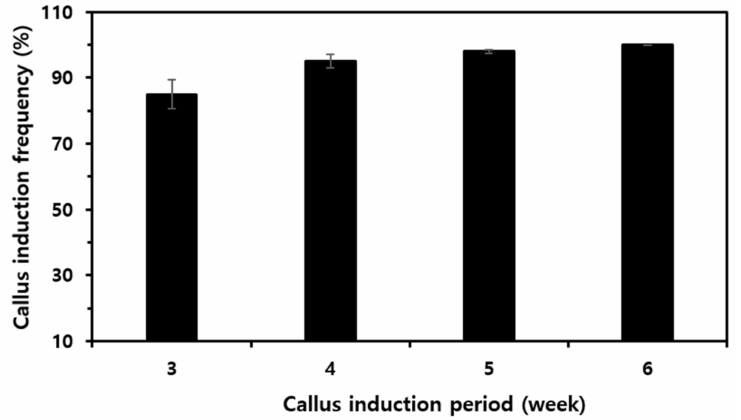
Figure 2. Frequency of callus induction from rice embryonic cells.